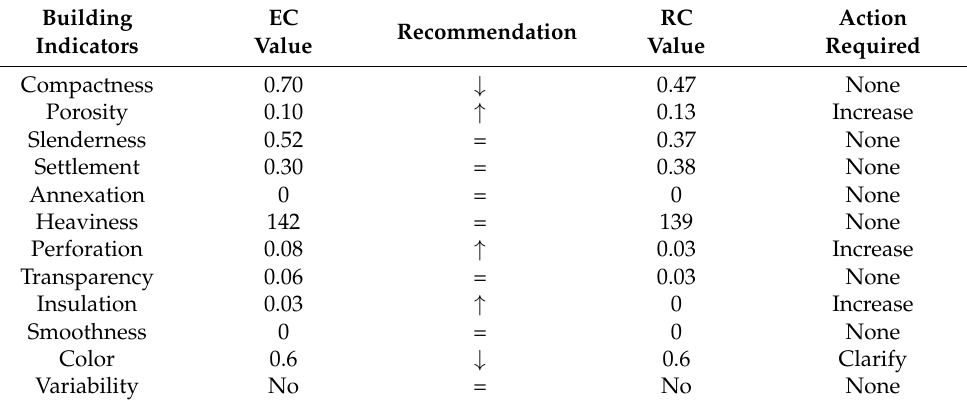
Table 5. Results obtained from the Serra and Coch coefficients for the EC and RC